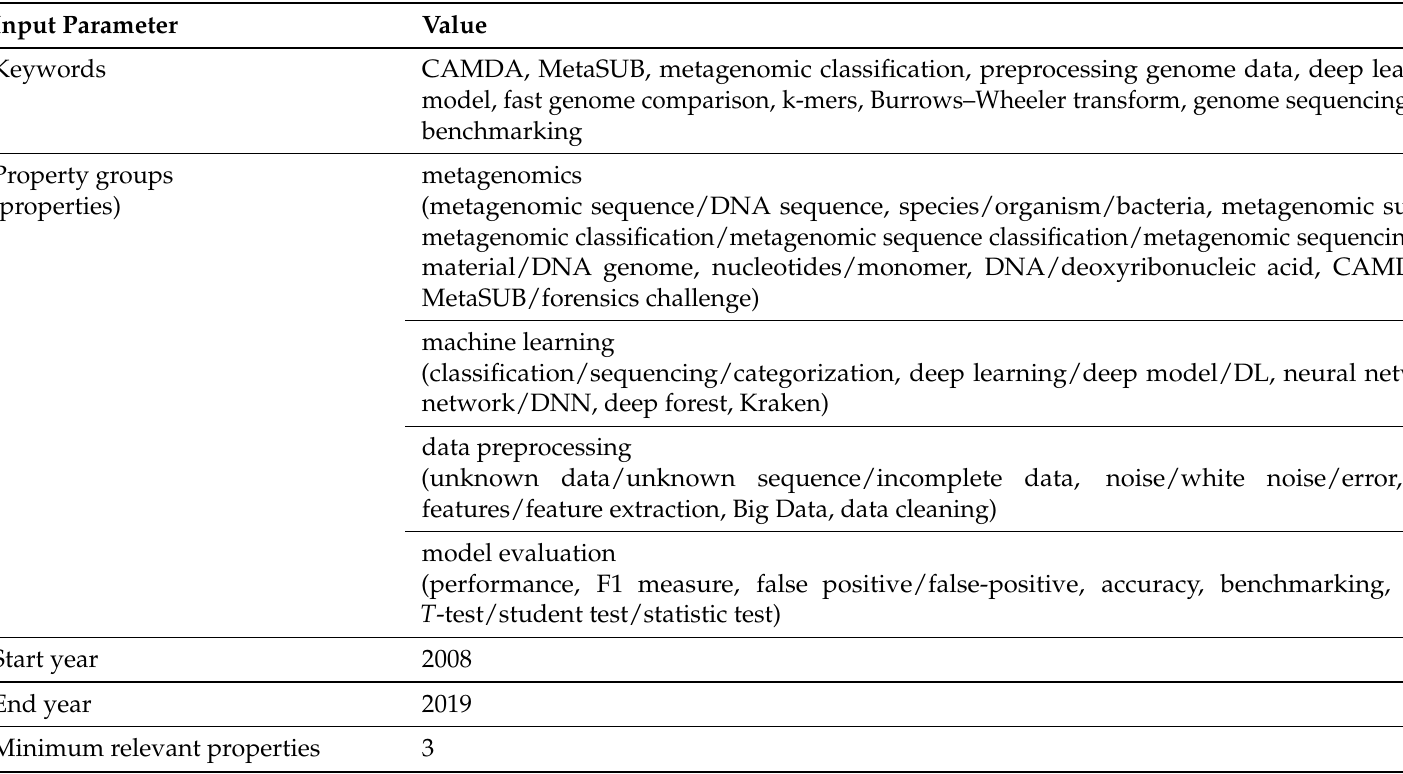
Table 1. NLP toolkit input parameters for the metagenomic sequencing scoping